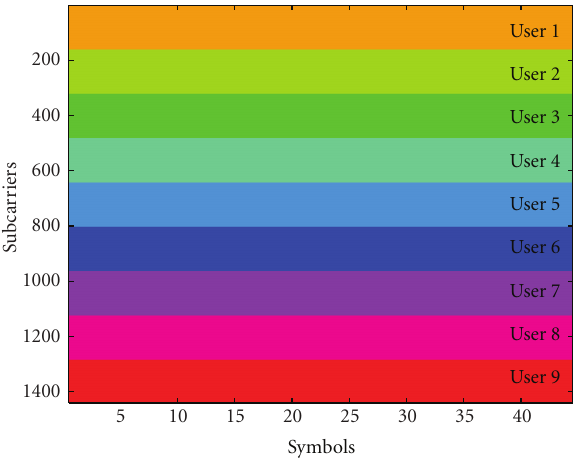
i , and varying r i = 2, for all i .